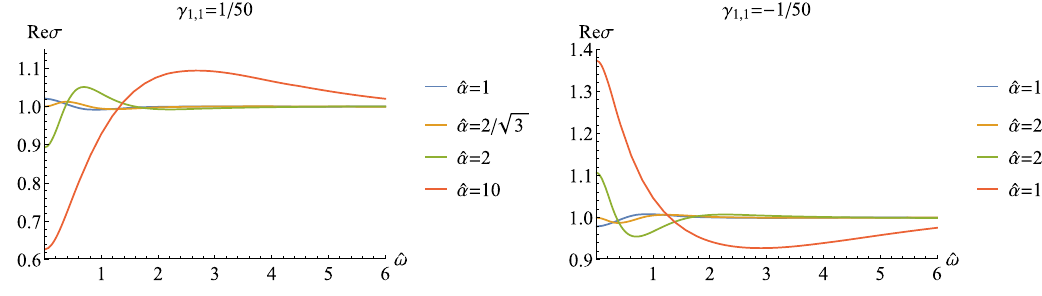
Fig. 12 The optical conductivity σ( ˆ ω) as the function of ˆ ω with representative γ 1 , 1 and ˆ α